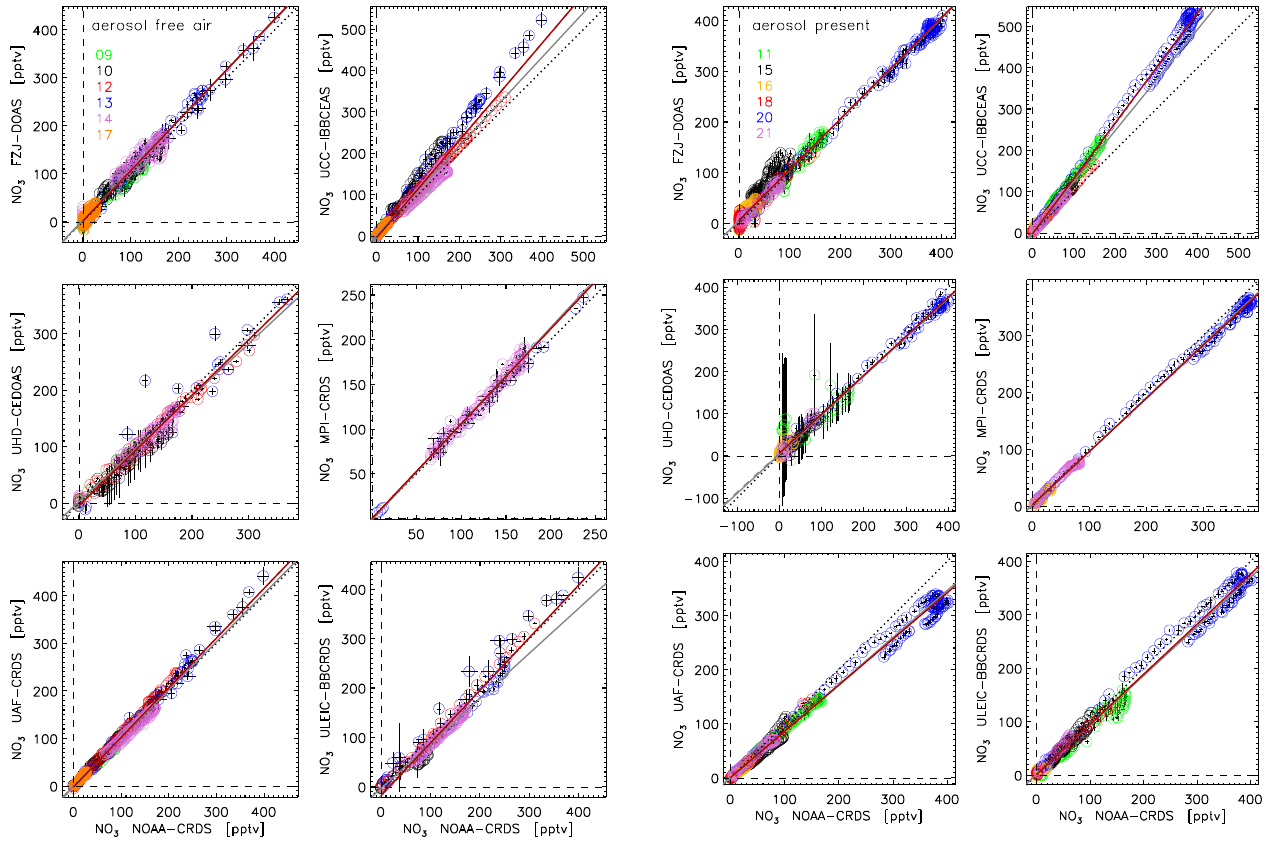
Fig. 5. Correlation of NO 3 measurements versus the reference in- strument NOAA-CRDS for aerosol-free conditions. The data sets were averaged onto a common 3min time grid, and the data range was limited to 420pptv to exclude any bias by the high mixing ratios of 13 June. The colour code denotes the experiment days and error bars are 1 σ . The “best-fit” line (dark-red solid line), calculated by a “least-normal-squares” regression method, represents the average instrumental response for the entire intercomparison and the dotted black line shows the ideal 1 : 1 line. The solid grey lines are the linear regression lines calculated by the “fitexy” algorithm. When the scatter of the data is significantly larger than expected from the measurement errors, the “fitexy” algorithm fails to determine the correct relation between the data pairs (cf. Sect. 3.3.2 and Table 3).